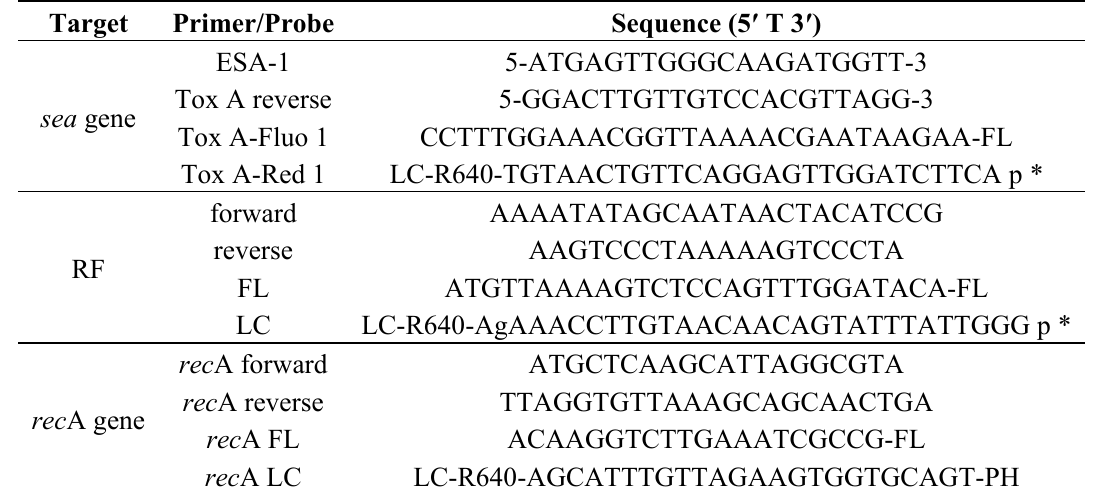
Table 1. Sequence of primers and probes with fluorescent dyes used for qPCR analyses of sea gene, replicative form of the bacteriophage genome (RF) and rec A